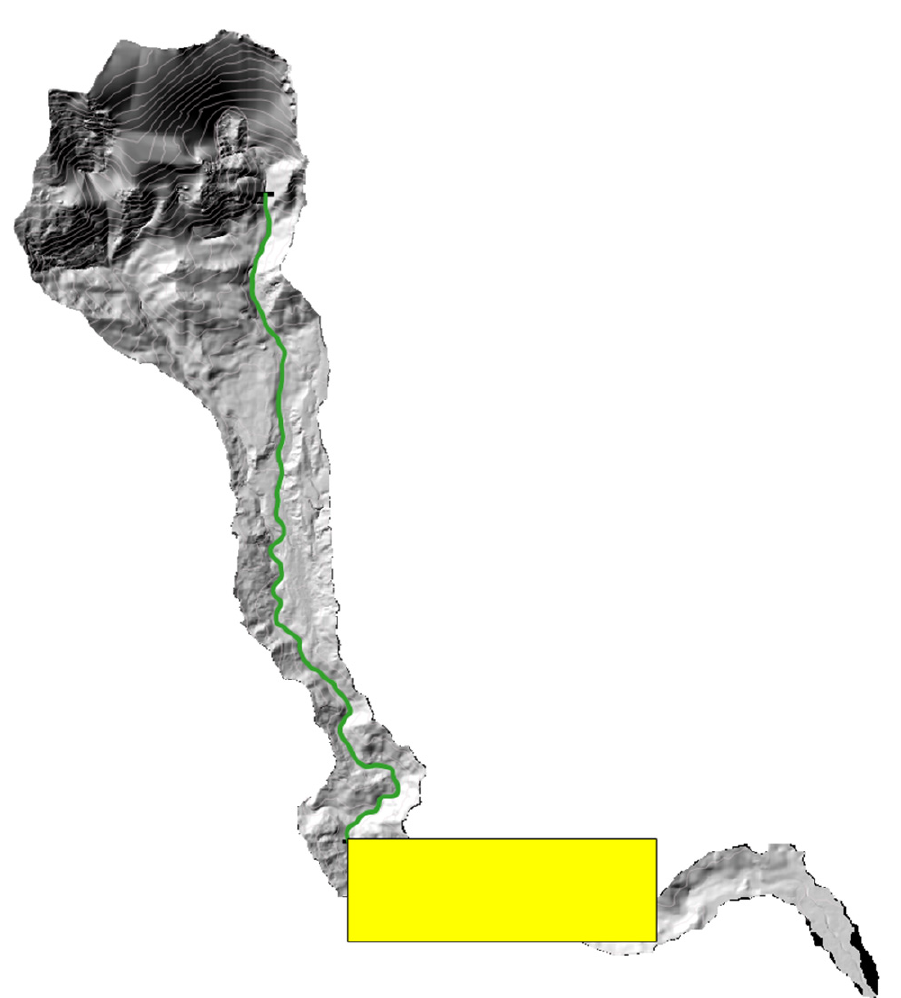
Figure 11. The setup of the HyperKANAKO model (the green line represents the runout area, and the yellow box indicates the deposition area).